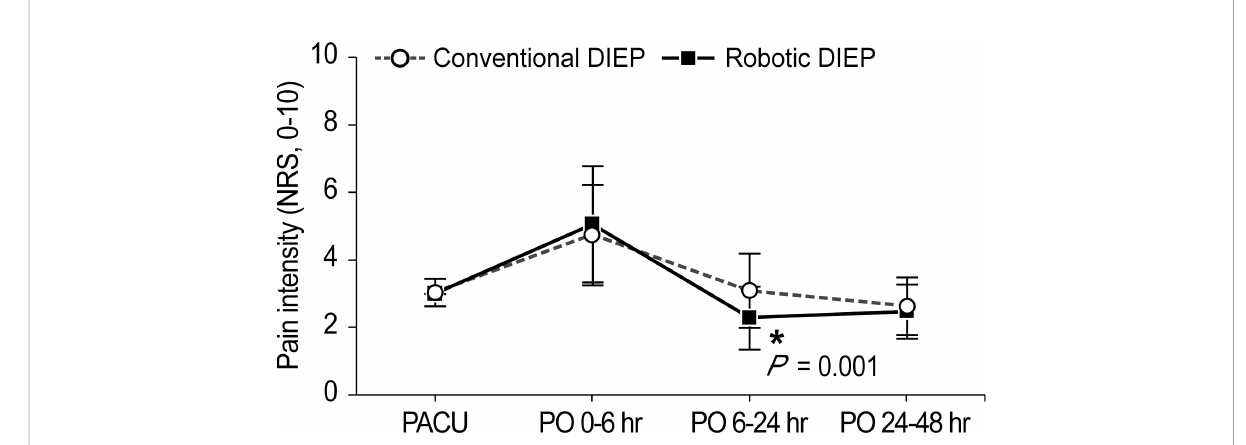
FIGURE 3 Pain intensity during the 48-h postoperative period. DIEP, deep inferior epigastric perforator; PACU, post-anesthesia care unit; PO, postoperative; NRS, numeric rating